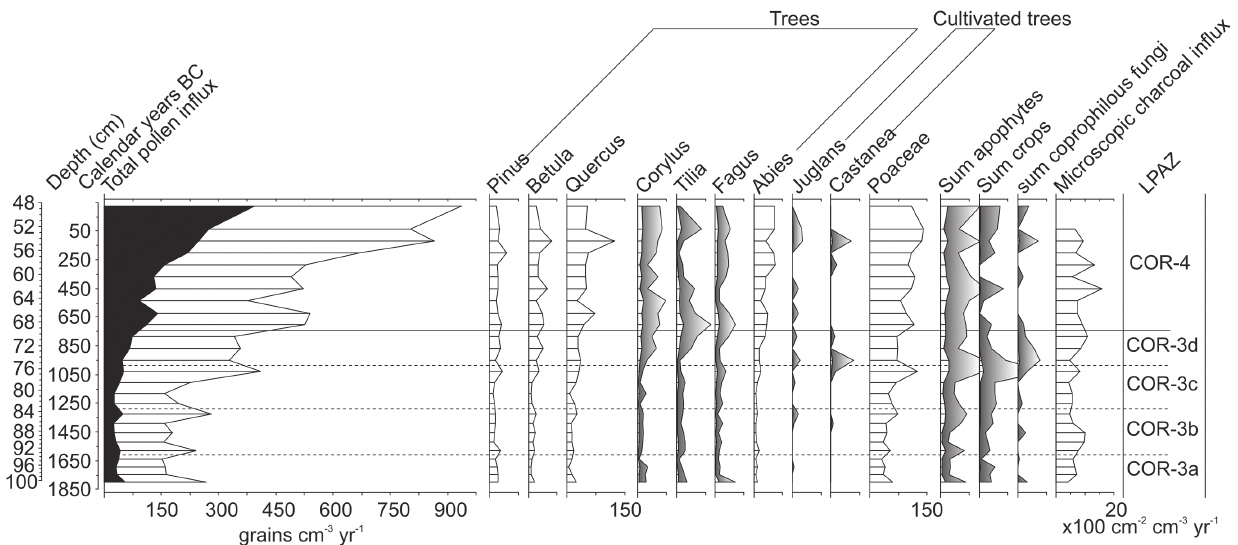
Fig 9. Pollen influx diagram showing total pollen influx with the Lactuceae curve overlaid (black), selected pollen types, sum of apophytes, sum of crops, sum of coprophilous fungi and microscopic charcoal influx plotted against the best fit from the smoothed spline Clam model. Exaggeration curves are x 5 for tree taxa and x10 for others. Pollen influx was calculated only for the region of the core where 14 C dates are present.